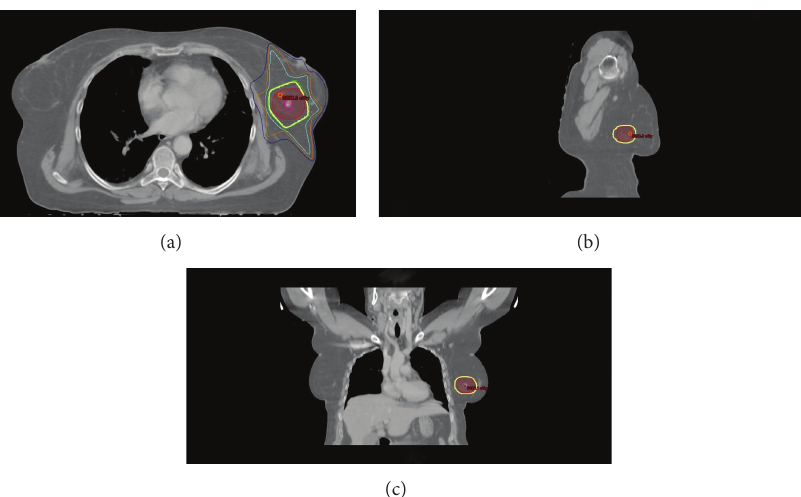
Figure 3: 3D conformation radiation therapy planning of MALT breast lymphoma. Dose distribution in the axial (a), sagittal (b), and (c) coronal planes. The red area indicates the planning target volume (PTV) and the yellow line indicates the 30 Gy isodose